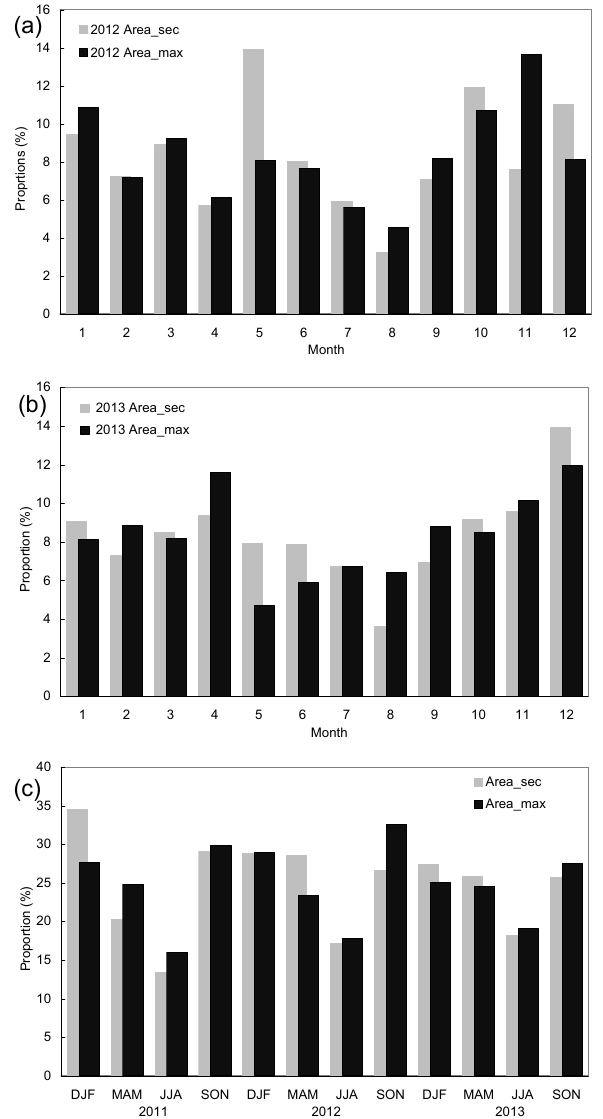
Figure 6. Proportions of flashes detected by WWLLN in Area_max and Area_sec: monthly (a) in 2012 and (b) 2013; (c) seasonally in the period